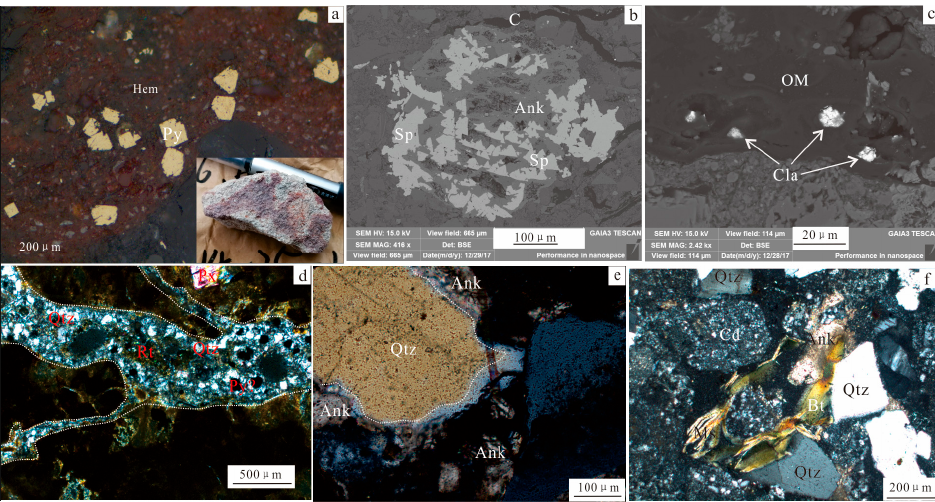
Figure 4. Macro-micrographs of hydrothermal alteration from dolerite and the lower member of Yaojia Formation in Qianjiadian ore field. ( a ) Hydrothermal pyrite is rapidly formed in oxidized sandstone, ( b ) Intergrowth of ankerite and sphalerite, ( c ) Selenite is wrapped in organic matter, ( d ) Siliceous veins containing metallic minerals, ( e ) Quartz fringe with alkaline dissolution and associated ankerite , ( f ) Biotitization of Muscovite. Hem: hematite; Py: pyrite; Ank: ankerite; Sp: sphalerite; OM: organic matter; Cla: selenite; Qtz: quartz; Rt: rutile; Px: pyroxene; Bt: biotite; Ms: muscovite, Cd: lithic debris.